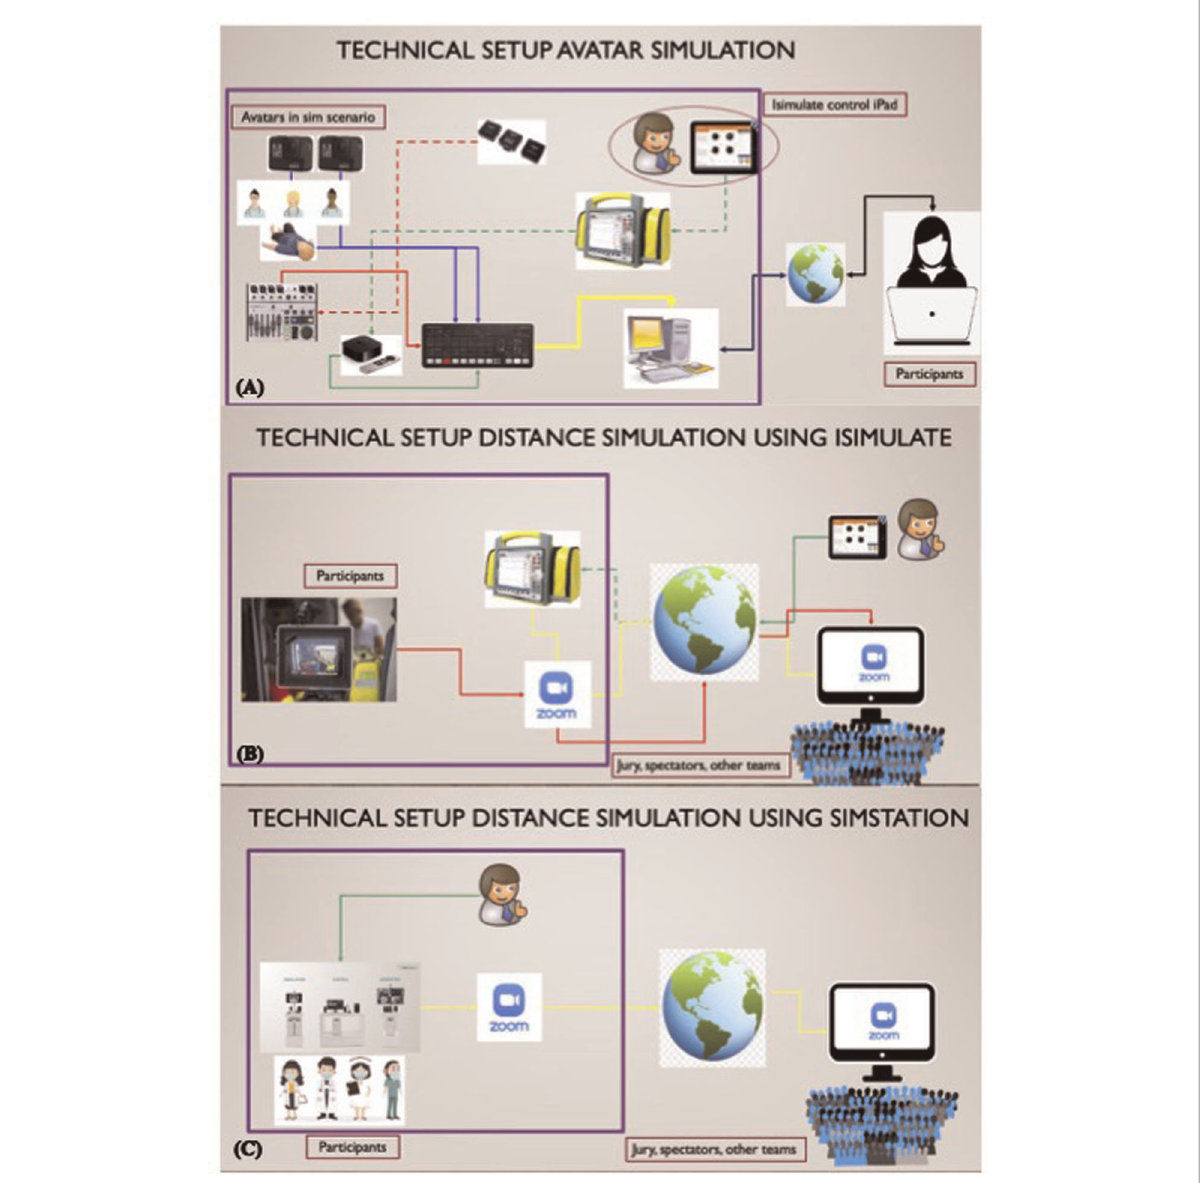
FIGURE 1 Concepts and technical setup of ( A ) avatar simulation and distance simulation using ( B ) iSimulate (iSimulate, Canberra, Australia and albany, New York, United States) or ( C ) SIMStation (©SIMStation, Vienna, Austria), respectively. Figures courtesy of Dr. Alberto Gyasi, Vienna, Austria. ( A ) On site: Control of the iSimulate monitor via the iSimulate control pad, which transmits the image of the monitor via radio to the Apple TV (Apple TV®, Apple Inc., United States) device. The Apple TV® device transmits the image to the video mixer [Atem mini (Blackmagic Design Pty. Ltd, Port Melbourne, Australia)] via HDMI. The two GoPro (©GoPro Inc., United States) cameras each transmit the action via HDMI to the video mixer. The Avatars transmit their sounds via wireless microphone to the wireless receiver. The wireless receiver feeds the sound to the video mixer via cable. The video mixer provides picture and sound to the participants via a virtual webcam over Zoom® (Zoom Video Communications, San Jose, California, United States). Participants side: Participants also use Zoom® to give instructions to the avatars via a speaker in the avatar room, allowing them to remotely control the avatars. ( B ) On-site: One iPad® (Apple Inc., United States) is used as an iSimulate patient monitor, another iPad® as a camera. Both must be connected to Zoom® to transmit the respective image. In the control center: The patient monitor can be controlled via an iPad®, which is connected to the monitor via internet. In addition, the two images from the remote simulation site are pinned (or brought into focus) on Zoom®. At a distance: That way the spectators and jury can follow the simulation. ( C ): On site: ©SIMStation (with inbuild cameras capturing the team and the monitor) needs to be connected to Zoom®. The patient monitor is controlled on site. At a distance: That way the spectators and jury can follow the